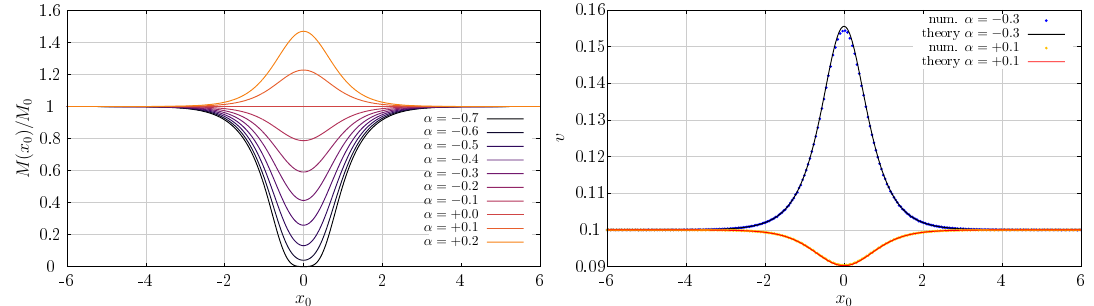
Figure 13 . E(cid:11)ective mass of the BPS solution (left) and velocity of the zero of the antikink, mea- sured from the full PDE evolution (dots) compared with the velocity obtained from equation (5.11) (solid lines) for initial velocity v = 0 : 1.